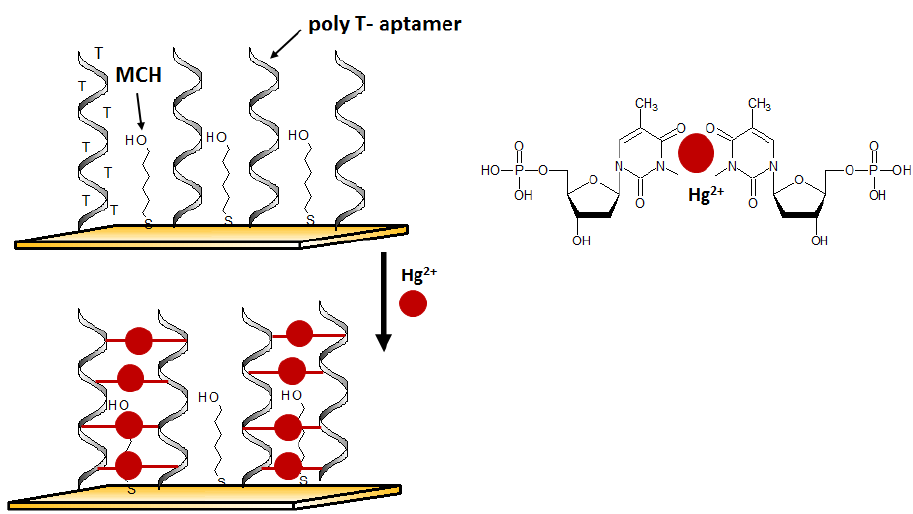
Figure 5. The sensing principle scheme of the electrochemical DNA sensor for mercury(II) ion.